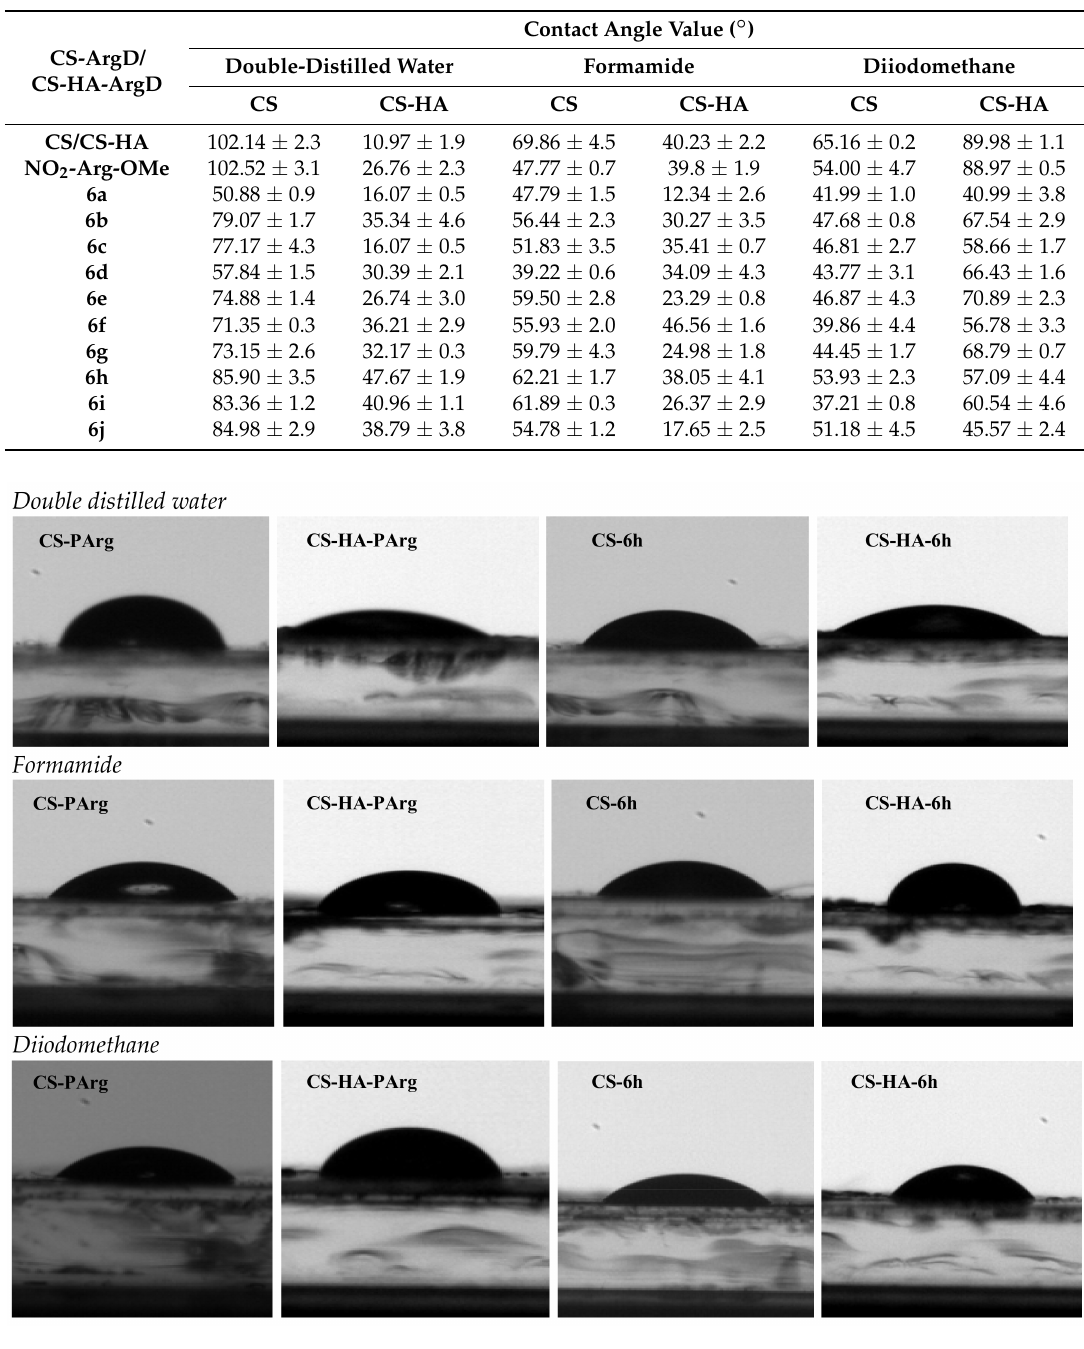
Figure 6. Recorded images at the contact angle measurements for CS-6f/CS-HA-6h and CS-PArg/CS-HA-PArg in double distilled water, formamide, and